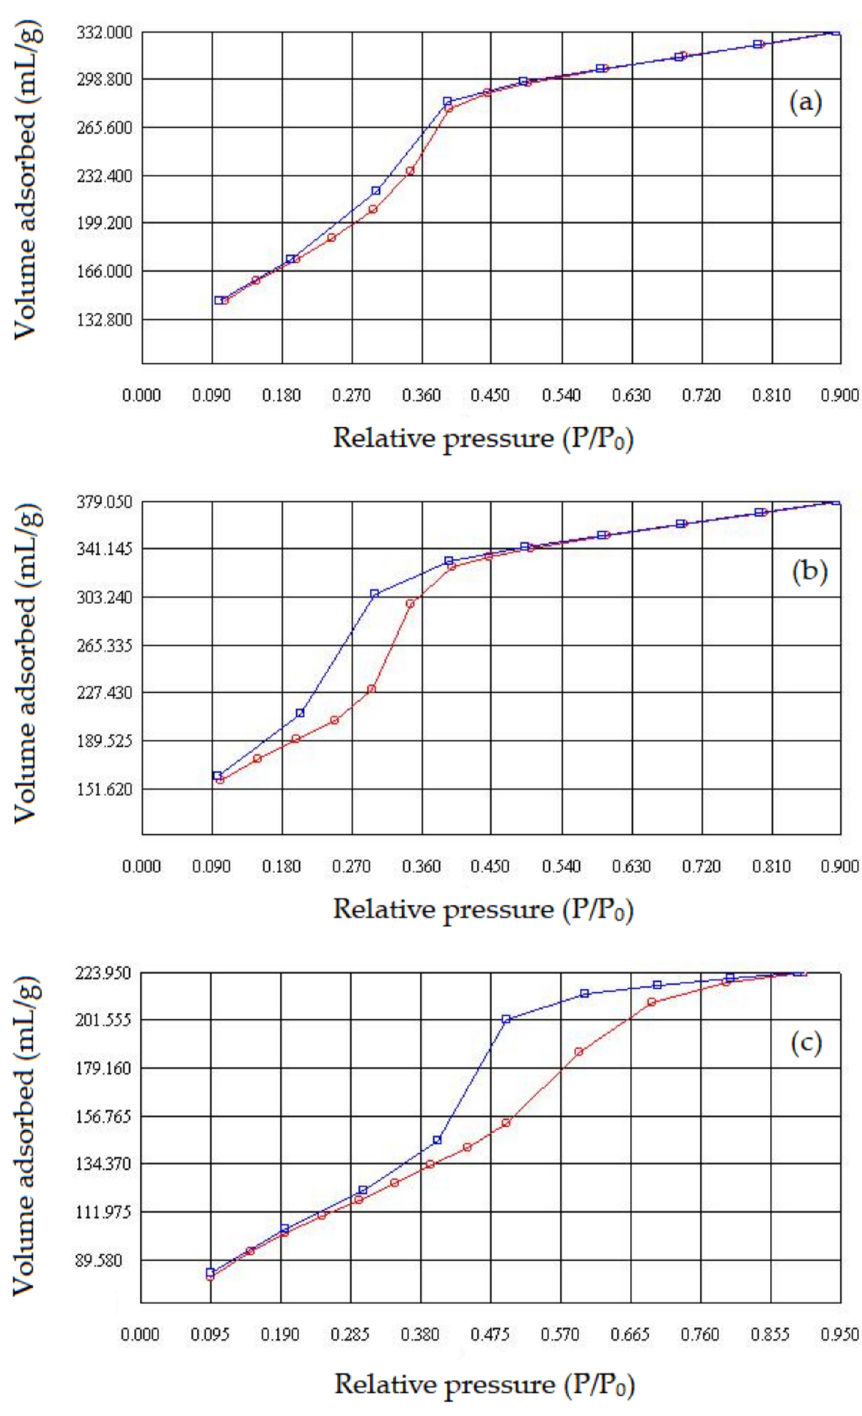
Figure 12. Nitrogen adsorption/desorption isotherms obtained at 77 K of calcined samples: ( a ) SiO 2 ; ( b ) La–SiO 2 and ( c ) Dy–SiO 2 .